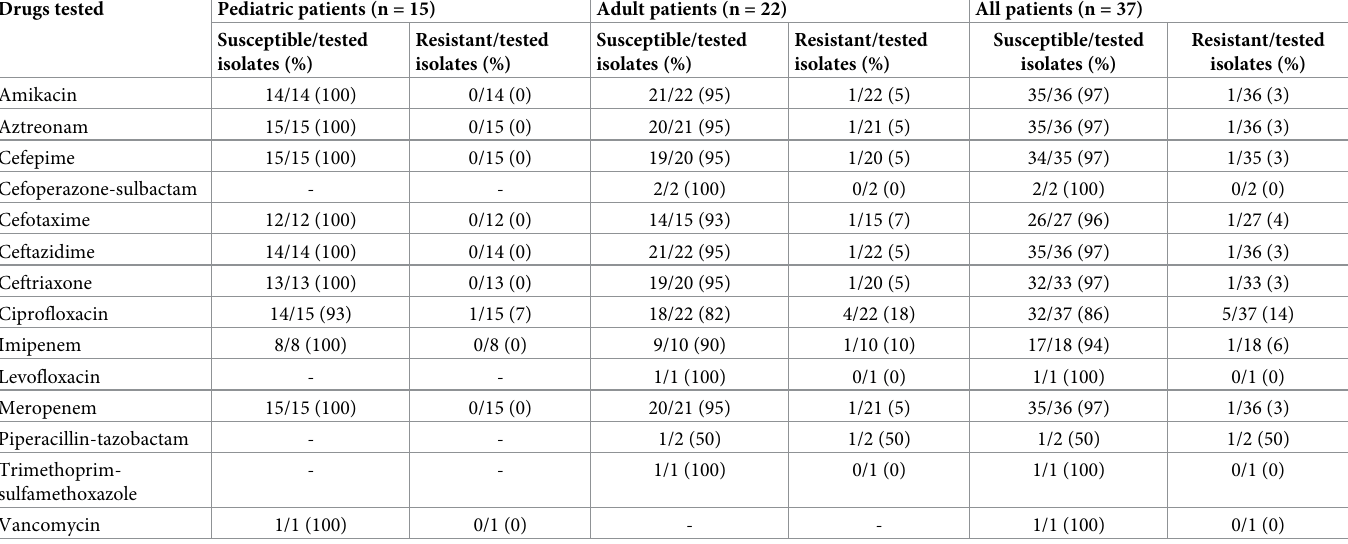
Table 4. Susceptible and resistant estimates of antibiotics of patients with hematological malignancies and Aeromonas sobria bacteremia in the overall population and according to age group. Drugs